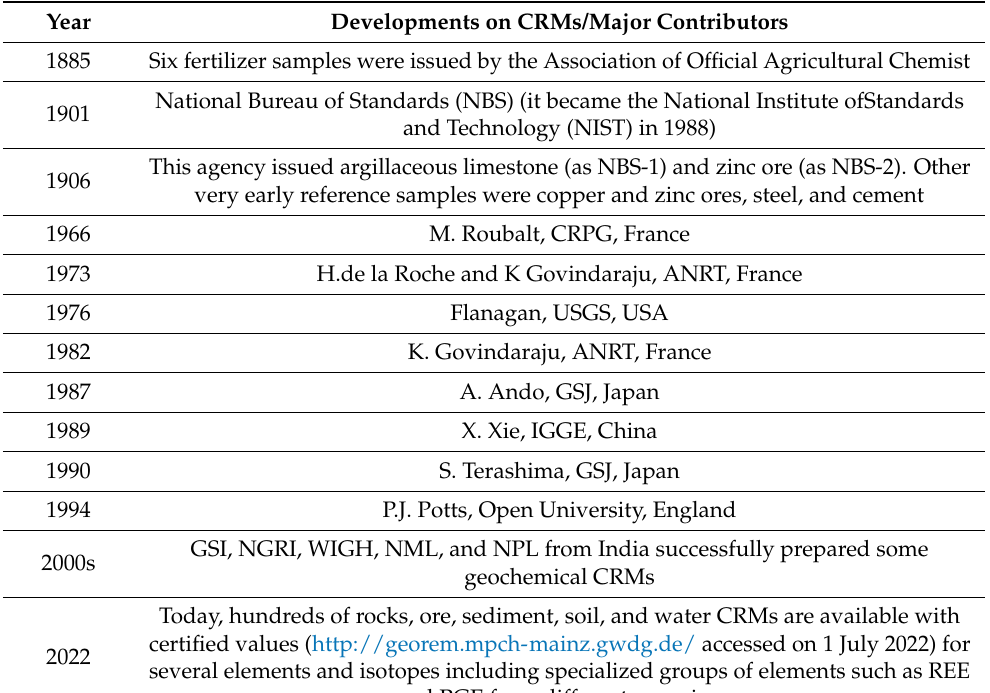
Table 4. Chronology and a brief summary of geochemical CRMs over 137 years of